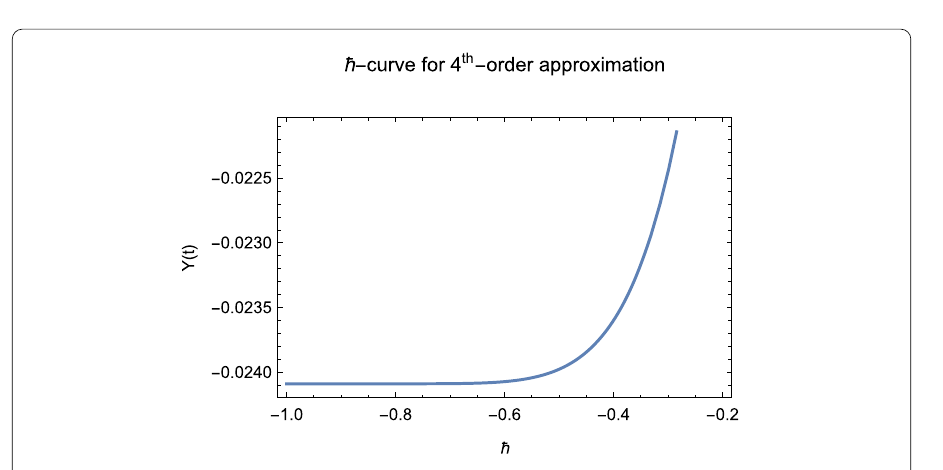
Figure 7 The h -curves of the fourth-order approximations for Y ( t )